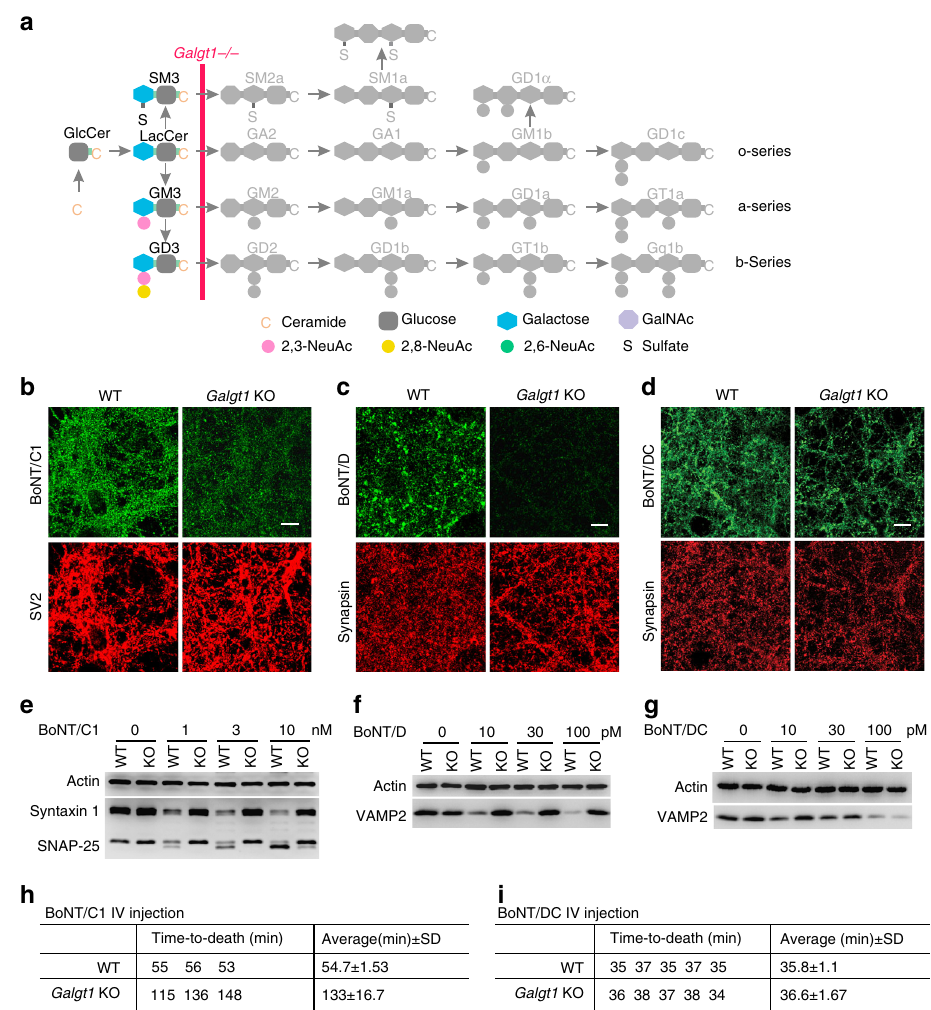
Fig. 2 Depleting all complex gangliosides did not affect binding and entry of BoNT/DC into neurons or its toxicity in vivo. a The step blocked in Galgt1 KO mice is marked on ganglioside synthesis pathways. b – d Experiments were carried out as described in Fig. 1b – d, except with cortical neurons cultured from Galgt1 KO mice. Binding of BoNT/C1 and BoNT/D-H C was greatly reduced in Galgt1 KO neurons. In contrast, binding of BoNT/DC-H C to Galgt1 KO and WT neurons was at similar levels. e – g Experiments were carried out as in Fig. 1e – g, except with cortical neurons cultured from Galgt1 KO mice. Entry of BoNT/ C1 and BoNT/D into Galgt1 KO neurons was blocked, while entry of BoNT/DC-H C into Galgt1 KO and WT neurons was at similar levels. h Rapid time-to- death assays were carried out for BoNT/C1. The same amounts of toxins (6 × 10 5 LD 50 /ml, 100 µ l) were injected into WT and Galgt1 KO mice. Time-to- death of each mouse was recorded. Galgt1 KO mice survived longer (133 min) than WT mice (55 min), re fl ecting a reduced sensitivity to BoNT/C1. SD standard deviation. i Rapid time-to-death assays were carried out for BoNT/DC as described in h (100 µ l, ~8 × 10 5 LD 50 /ml). Galgt1 KO mice showed survival time similar to WT mice when injected with the same amount of BoNT/DC, suggesting that Galgt1 KO and WT mice have similar sensitivity to BoNT/DC. One of two ( b – d ) or three ( e – g ) independent experiments is